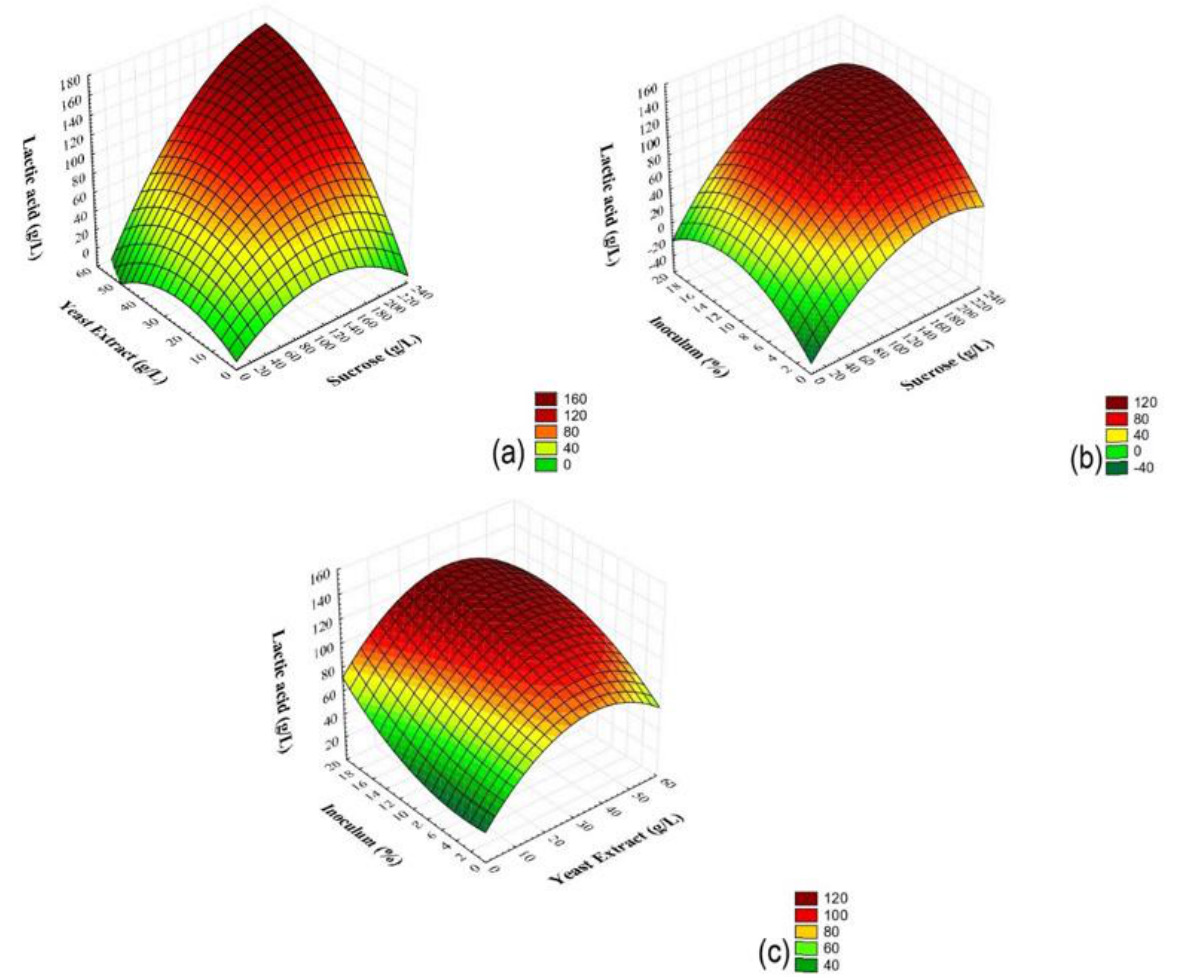
Figure 2. Response surface for lactic acid production by Lactobacillus casei Ke11 as function of variables ( a ) sucrose (X 1 ) and yeast extract (X 2 ); ( b ) sucrose (X 1 ) and percentage of inoculum (X 4 ); ( c ) yeast extract (X 2 ) and percentage of inoculum (X 4 ).